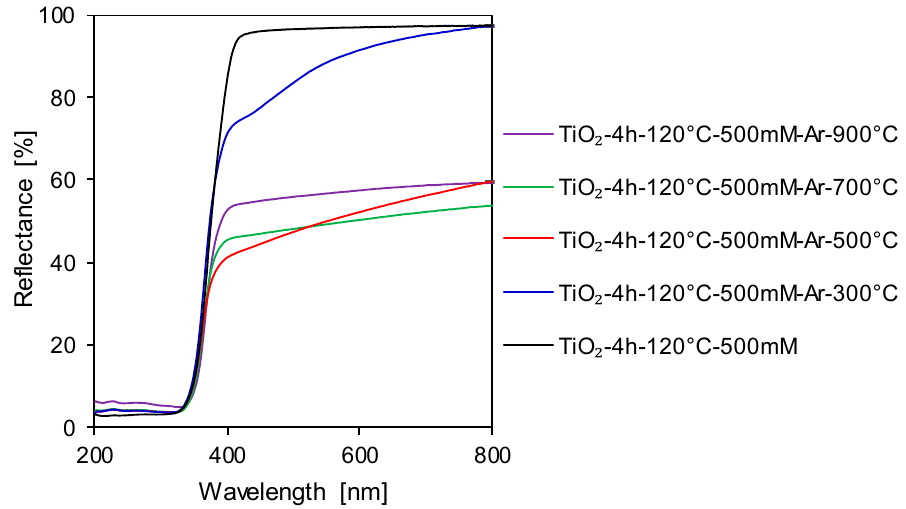
Figure 4. Ultraviolet–visible diffuse reflectance spectra (UV–Vis/DRS) of and APTES-modified TiO 2 prior and after calcination process. Table 2. The carbon and nitrogen content, and zeta potential values of starting TiO 2 , reference samples and APTES-modified photocatalysts prior to and after the calcination process.